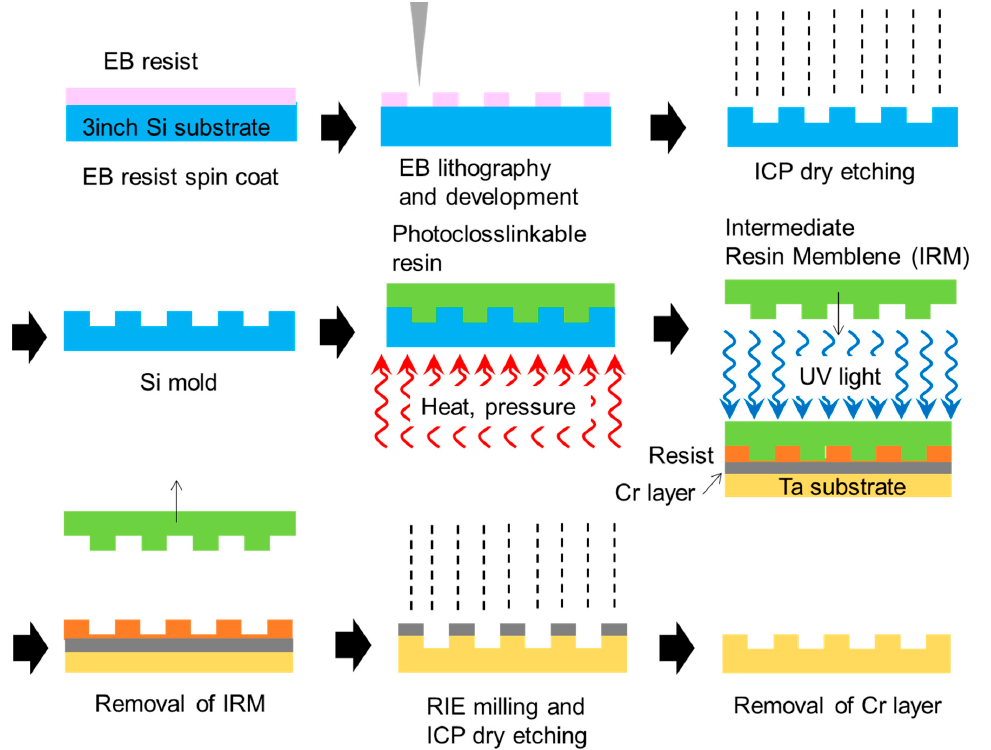
Figure A1. Nanoimprint process for fabricating microcavity filaments.